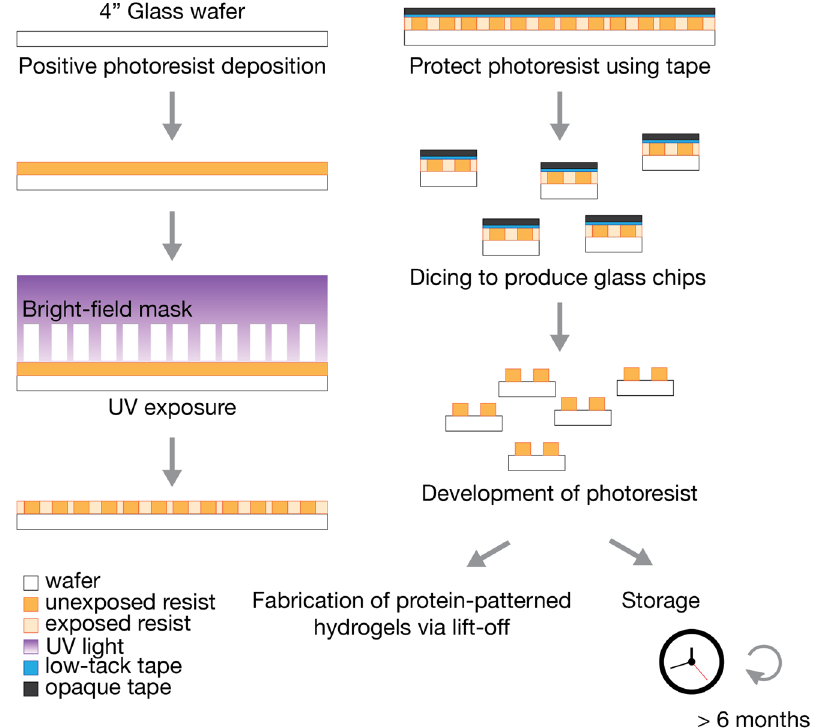
Figure 1. Wafer fabrication of 4” glass wafers using photolithography, from photoresist deposition to dicing to obtain individual glass chips, and development of the photoresist. Developed glass chips can be stored for at least six months in a light-protected environment prior to the fabrication of protein-patterned hydrogels.